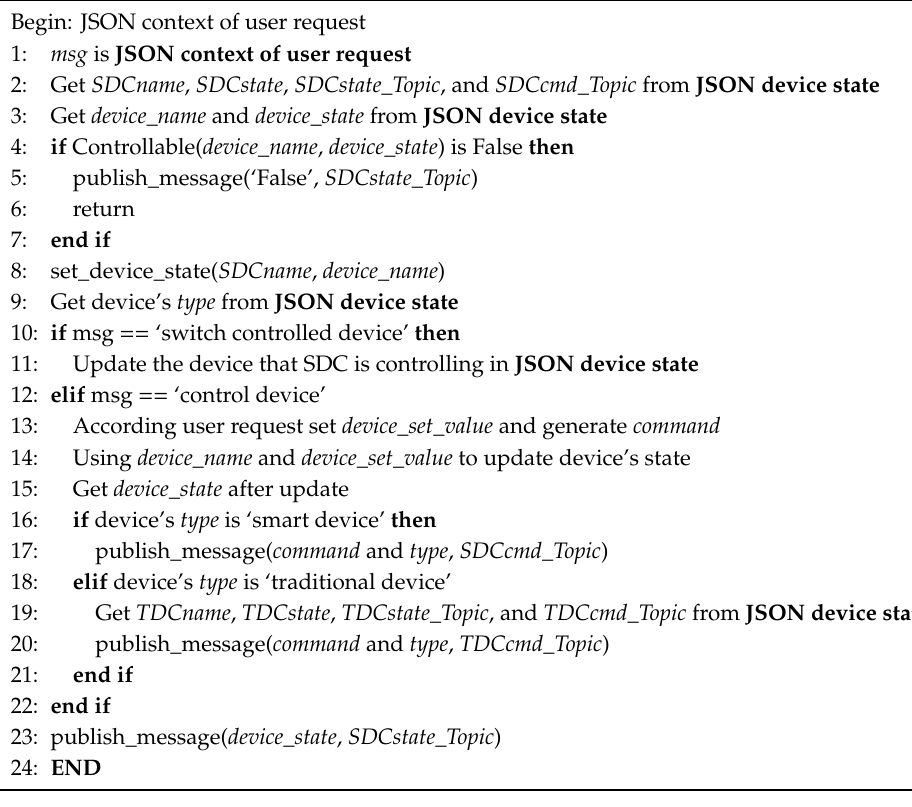
Algorithm 2. Logic Control of